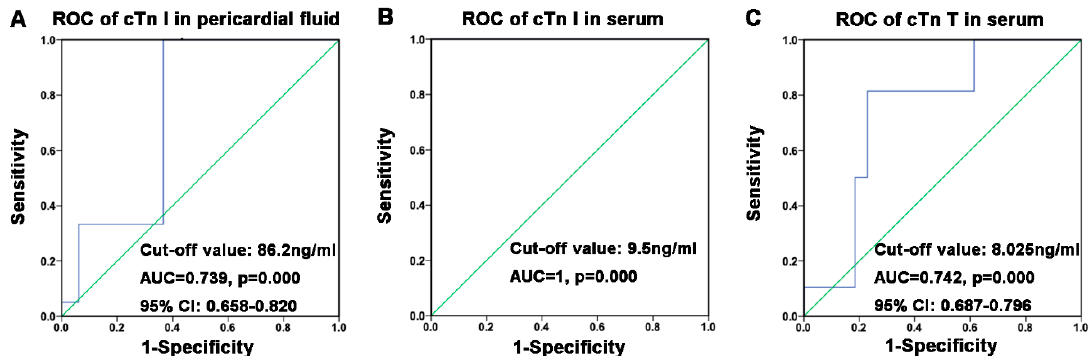
Figure 6. Receiver operating characteristic (ROC) curve of cardiac troponins in pericardial fluid and serum: ( A ) ROC of cTn I in pericardial fluid; ( B ) ROC of cTn I in serum; ( C ) ROC of cTn T in serum.